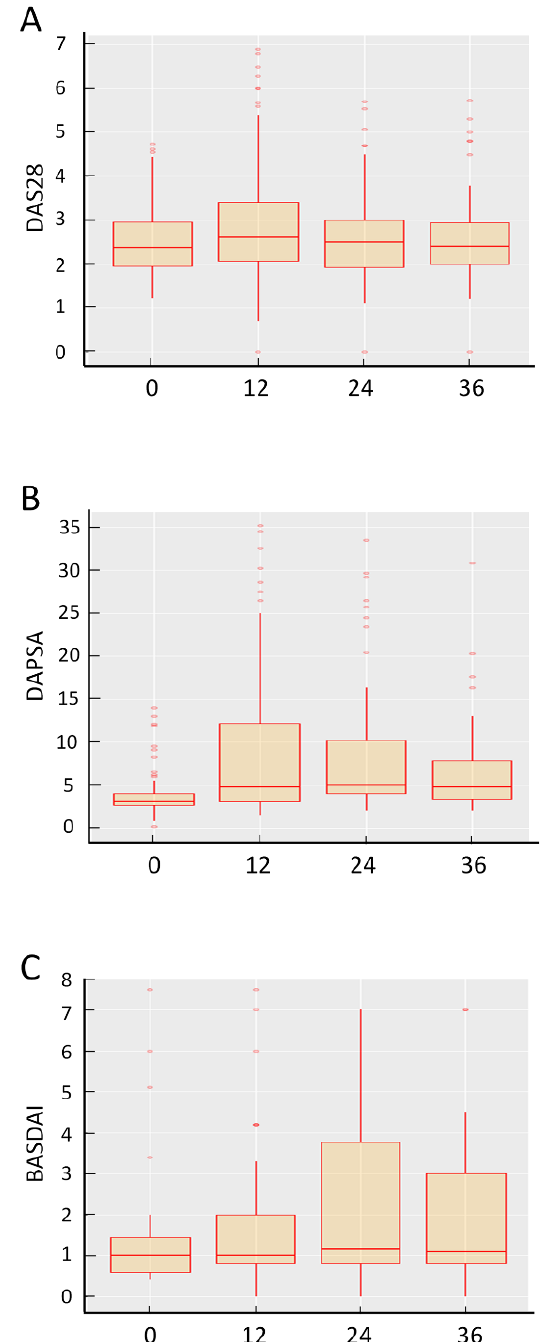
Figure 2. Box and whisker plots illustrating changes in disease activity for the different pathologies (RA, PsA and AS) over the follow up period. ( A ) DAS 28 was measured in RA patients, ( B ) DAPSA in PsA patients and ( C ) BASDAI in AS patients, respectively, at baseline and after 3 years of treatment with SB4. Data presented as median, 25th/75th percentiles and maximum/minimum recorded values. Orange open dots represent standard outliers (fall between 1.5 × IQR and 3.0 × IQR outside of the IQR,) whereas red full dots represent extreme outliers (fall greater than 3.0 × IQR outside the IQR).